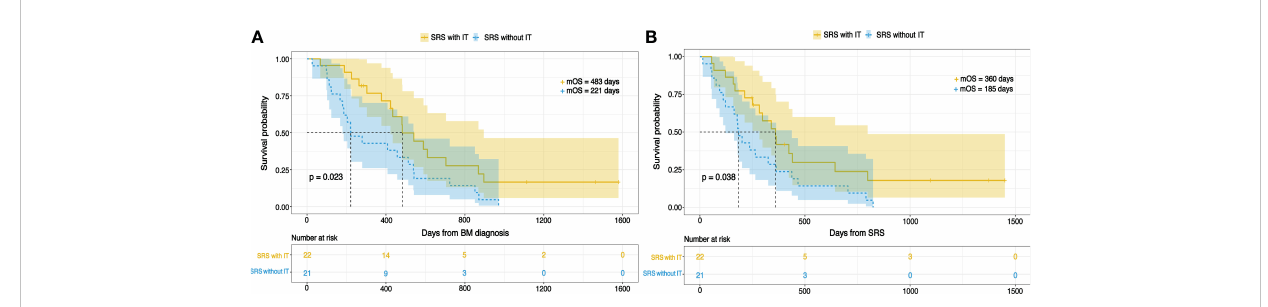
FIGURE 3 The Kaplan-Meier curves for OS in NSCLCBM patients treated by SRS with IT or SRS without IT from (A) BM diagnosis (B) SRS.